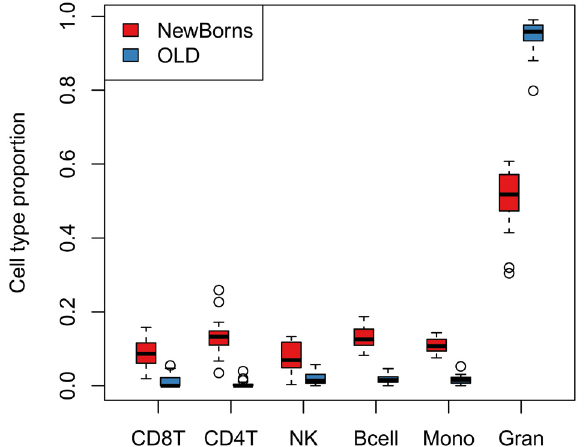
Figure 15. If samples come from a population of mixed cells e.g. blood, it is advisable to check for potential confounding between differences in cell type proportions and the factor of